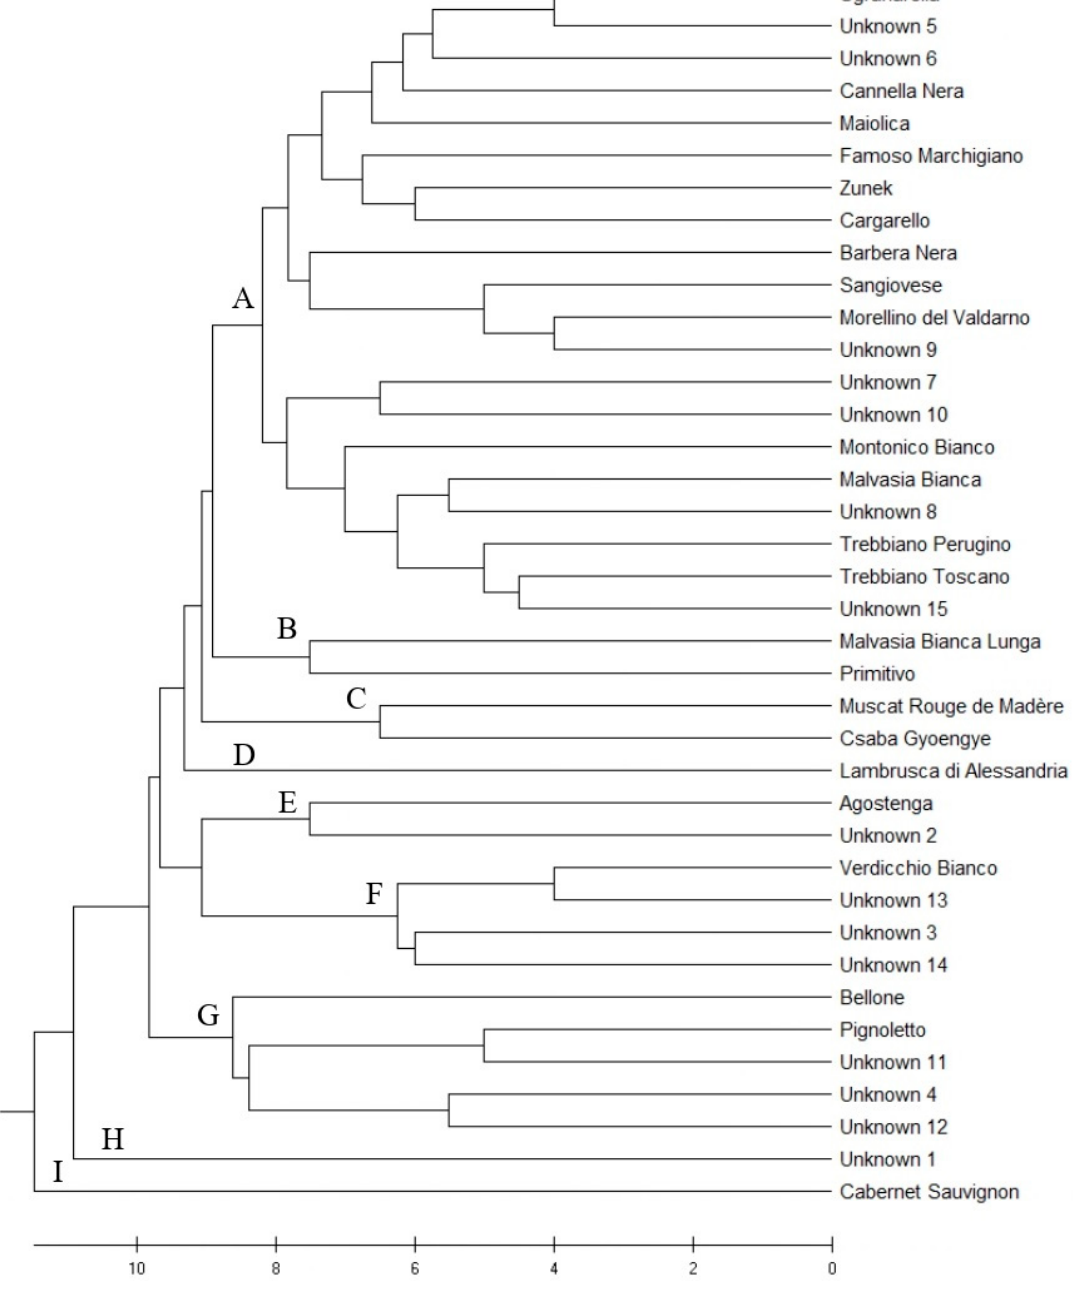
Figure 2. Dendrogram of genetic similarity of 38 genotypes with 12 SSR markers. The optimal tree was inferred using the UPGMA method [15] and MEGA X software [16]. The tree is drawn to scale, with branch lengths in the same units as those of the genetic distances used to infer the tree. The genetic distances were computed using GenAlEx software.